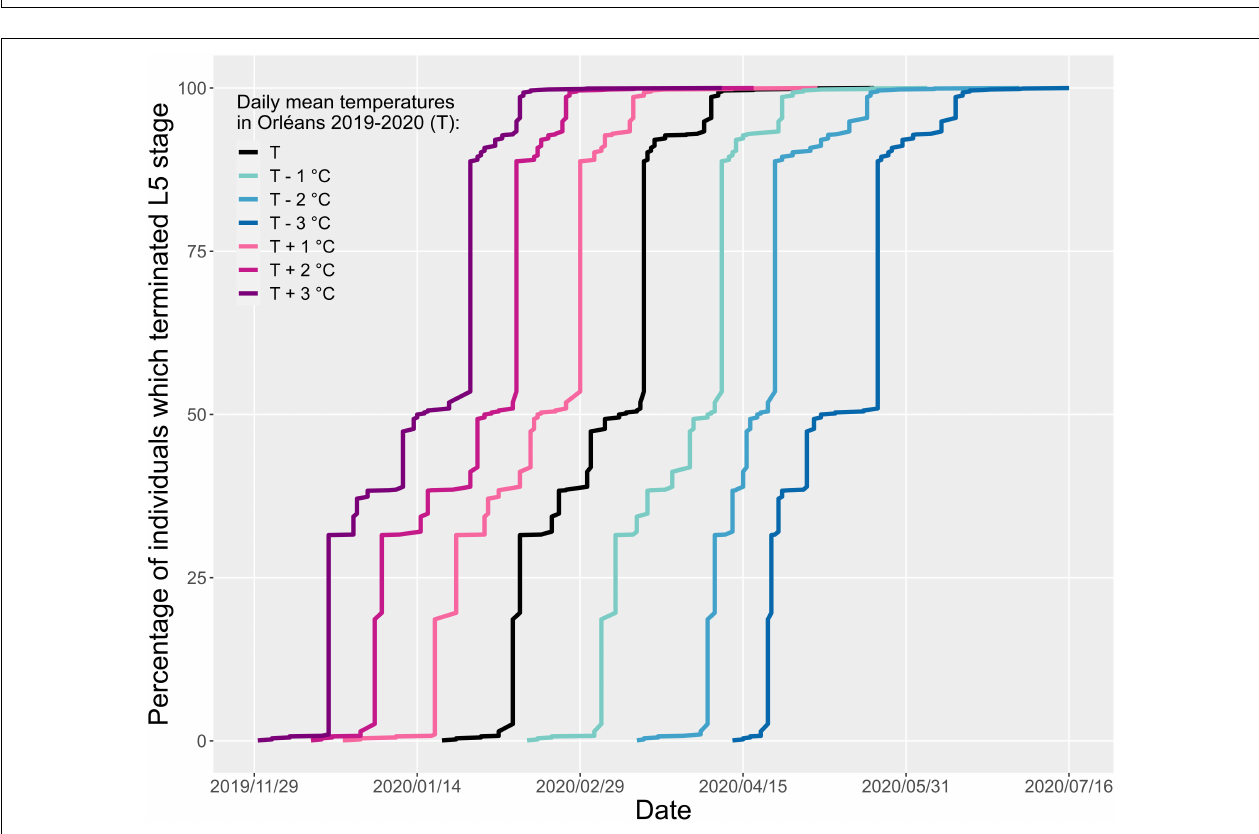
FIGURE 6 | Observed and predicted percentages of individuals in each stage present at each of eight monitoring dates. Bars represent observed percentages (mean of percentages obtained in sampled nests). Error bars: mean percentages ± standard deviation. Points represent percentages predicted by the phenological model.